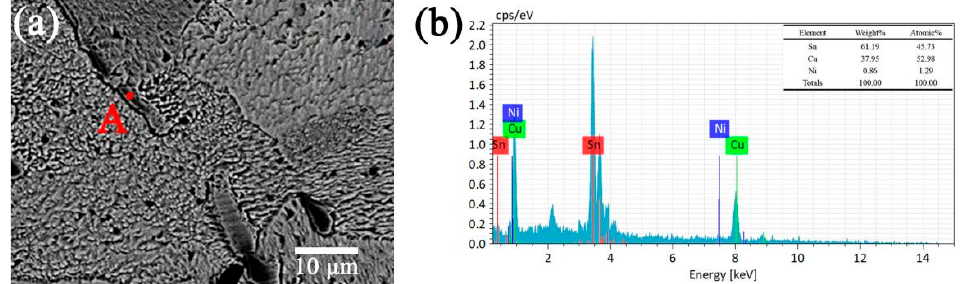
Figure 6. Microstructure ( a ) and EDS ( b ) of Sn-0.7Cu-0.08 wt.% Ni@C.